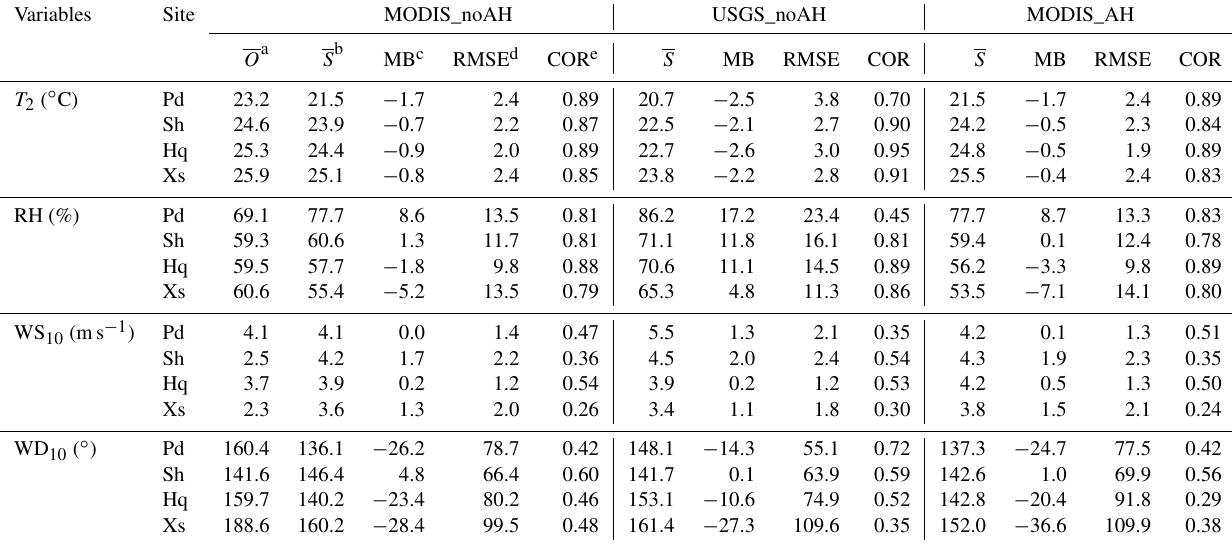
Table 4. Statistical metrics in meteorological variables between observations and simulations. Variables